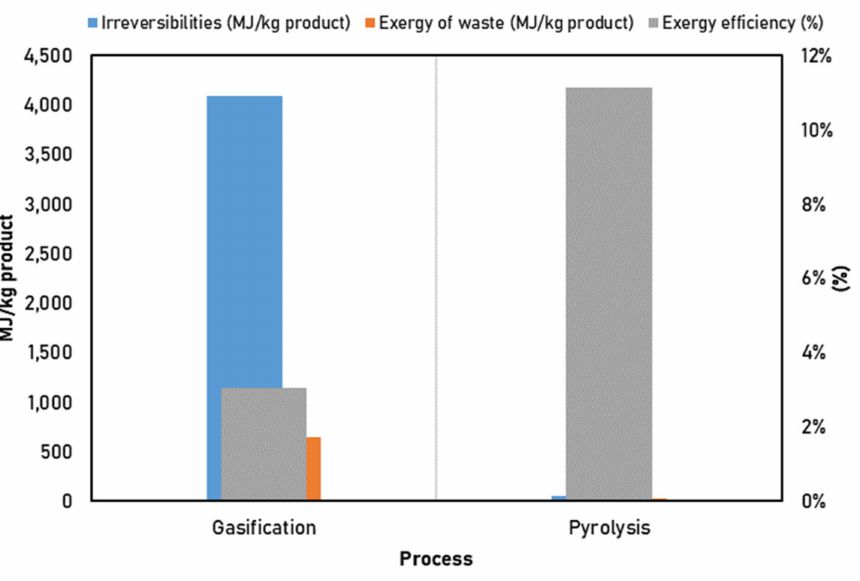
Figure 4. Exergy results of pyrolysis and gasification processes. Table 6. Summary of targets, current value, and percent score of sustainability indicators.